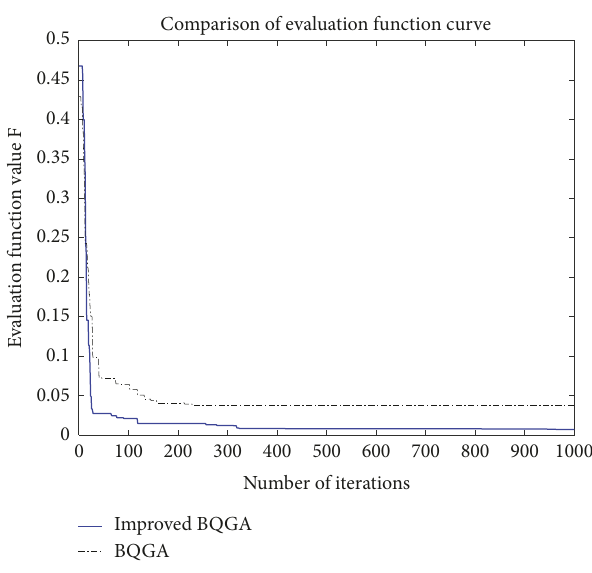
Figure 2: Comparison of evaluation function